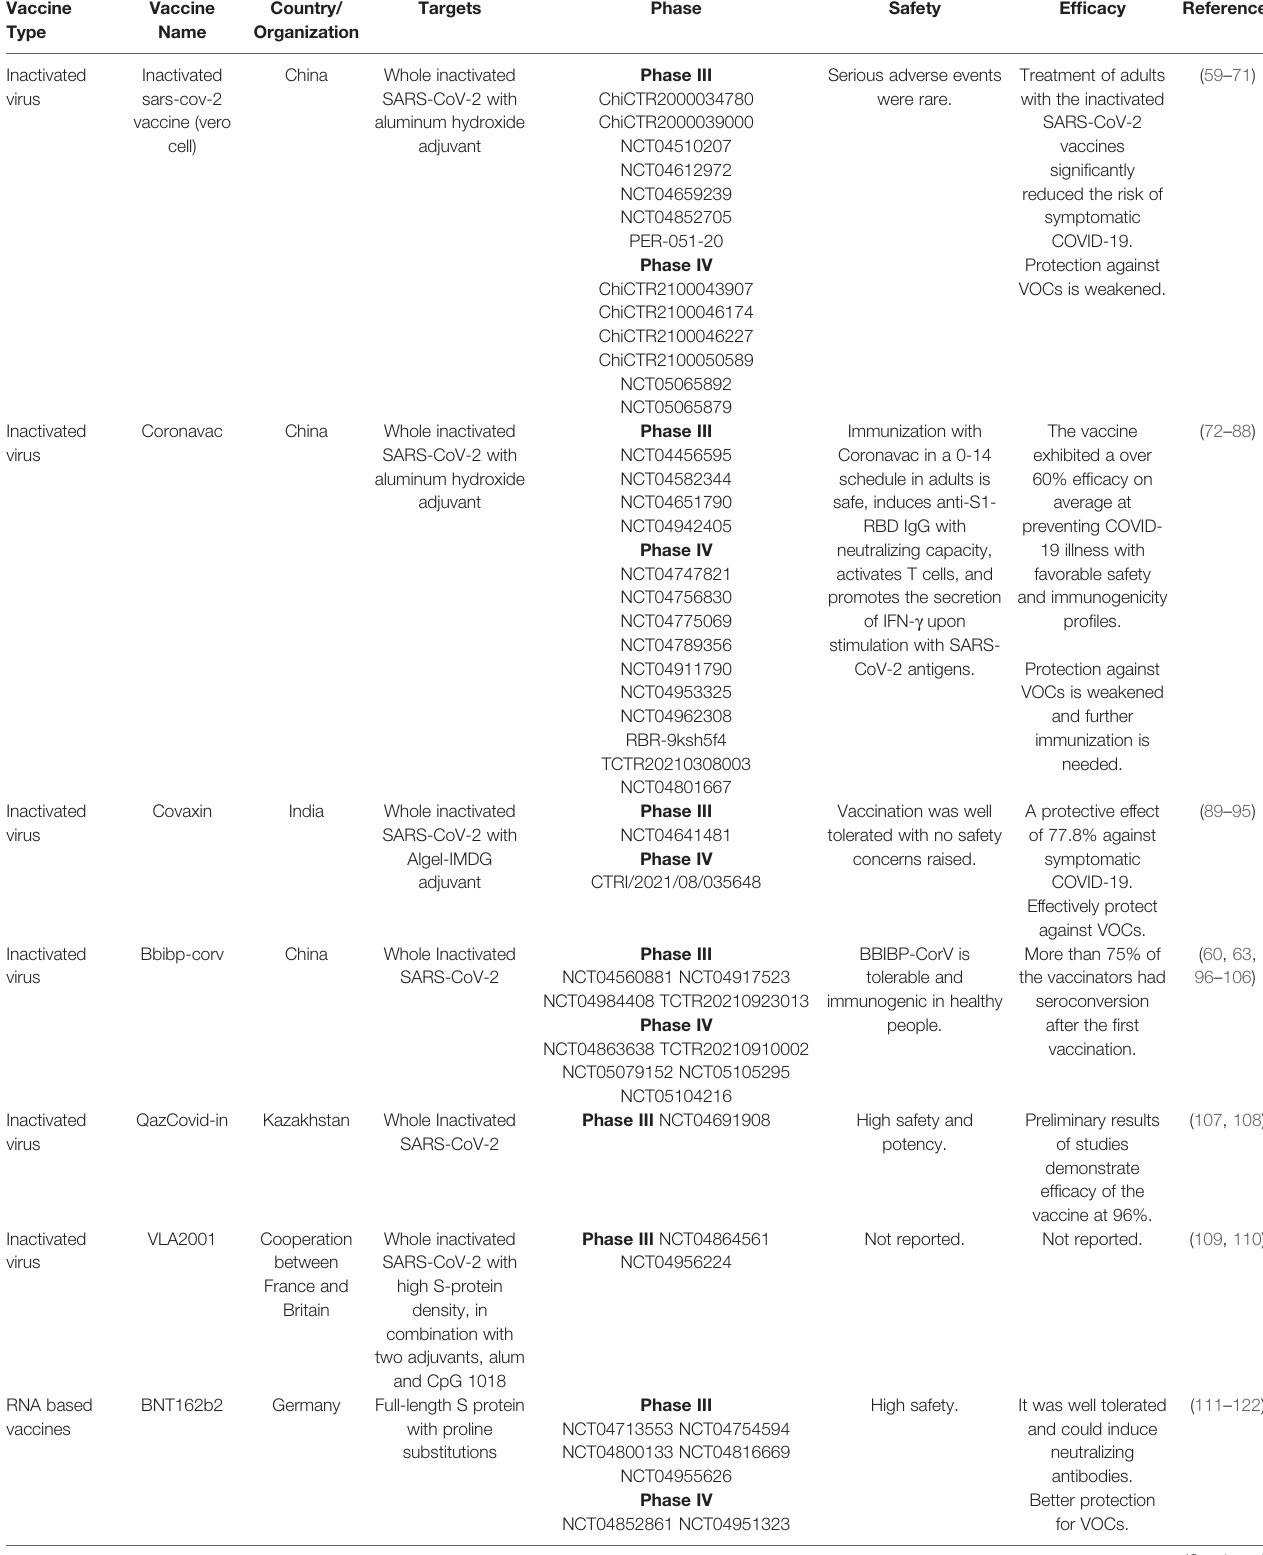
TABLE 1 | SARS-CoV-2 vaccine candidates in clinical phase III and